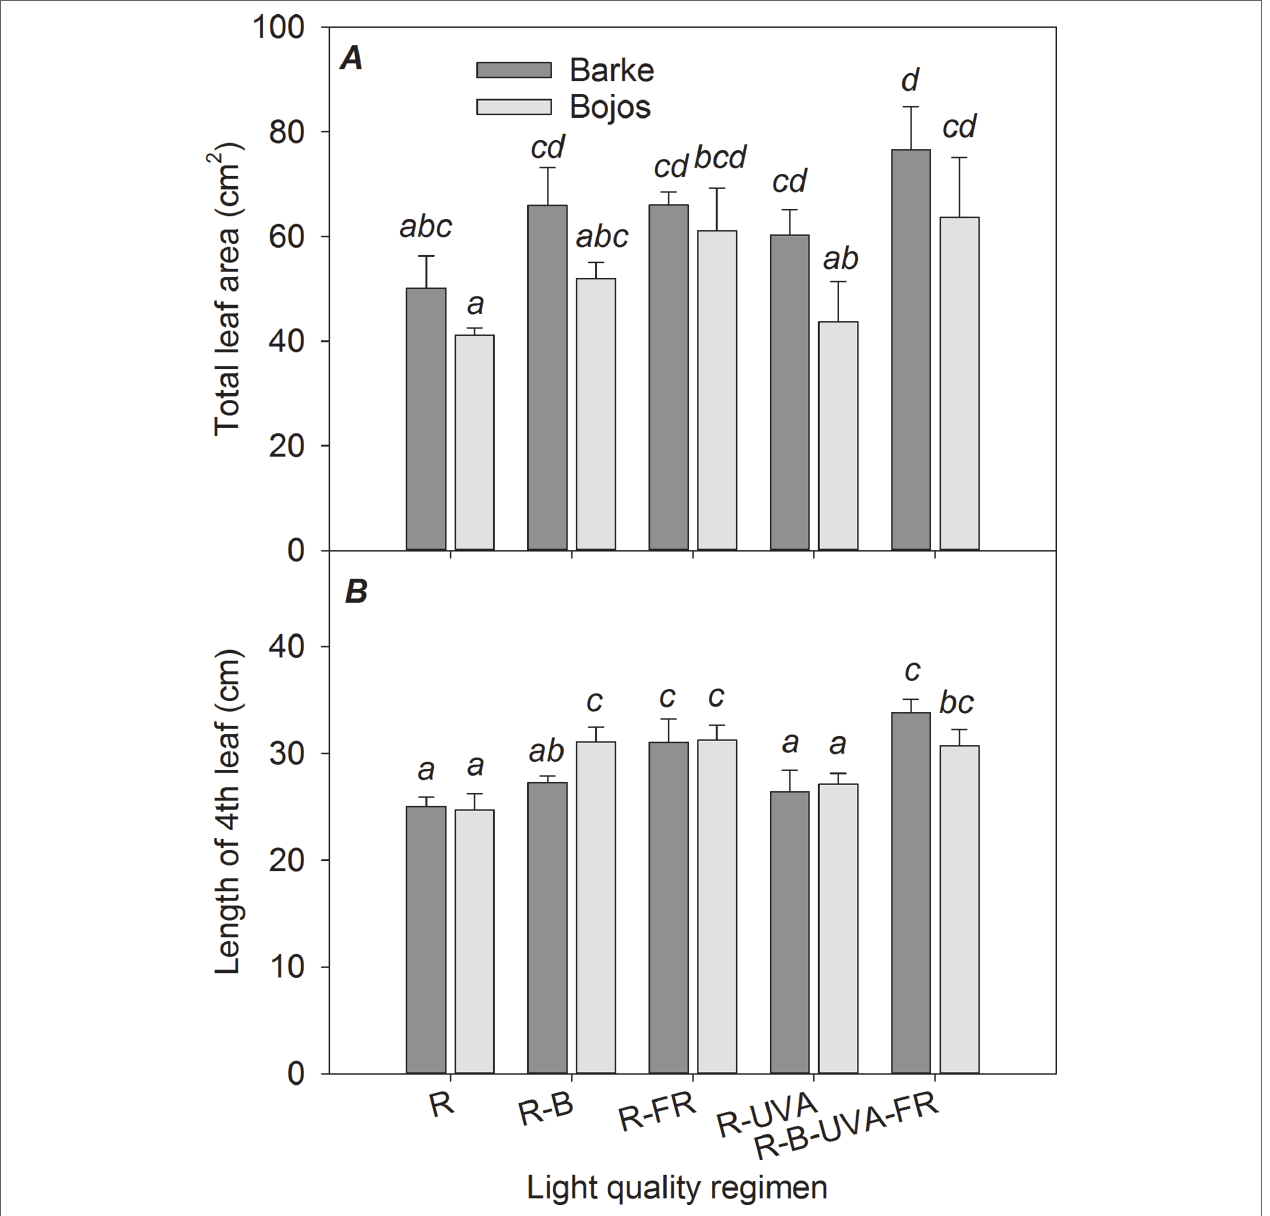
FIGURE 1 | Effect of 26 days exposure to different light regimens on total leaf area per plant (A) and length of the last completely developed (4th) leaf (B) of spring barley varieties Barke (dark grey) and Bojos (light grey). Here and in subsequent figures: R, only red radiation; R-B, red and blue radiation (1:1 ratio of photon flux density); R-FR, red and far-red radiation; R-UVA, R and UV-A radiation; R-B-FR-UVA, red and blue radiation (1:1 ratio of photon flux density) with far-red and UV-A radiation. All treatments used a photosynthetic photon flux density of 130 µmol m −2 s −1 . Column height indicates mean, vertical bars indicate standard deviations ( n = 4), and different letters indicate significant differences ( p ≤ 0.05) based on Tukey’s ANOVA post hoc